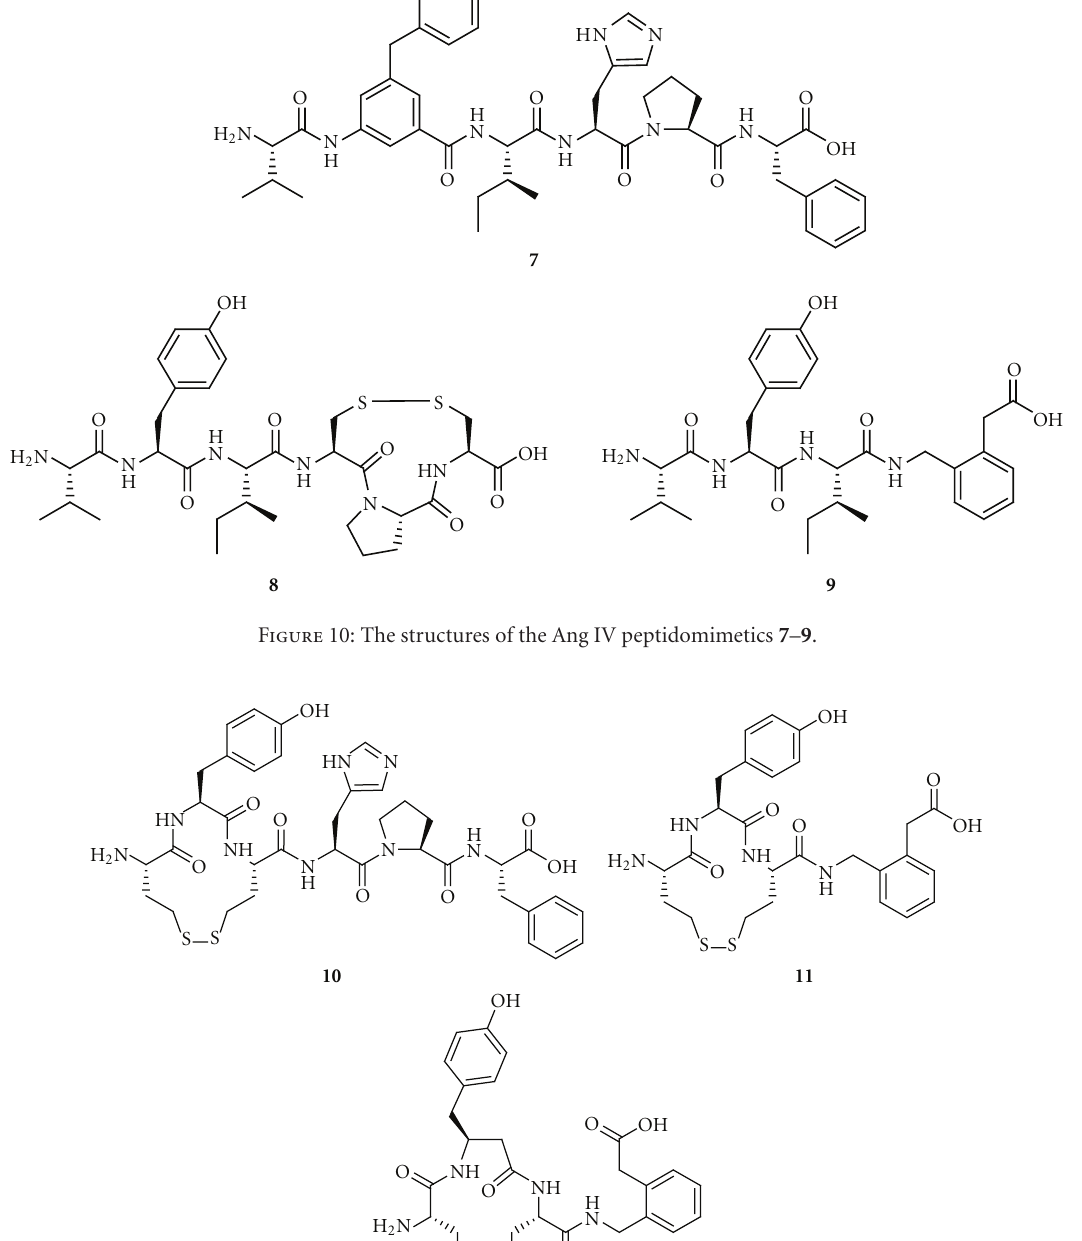
Analogues 5 and 6 (Figure 9), for example, inhibit IRAP to a very low degree. This suggests that the orientation of the Tyr 2 side chain is critical for activity